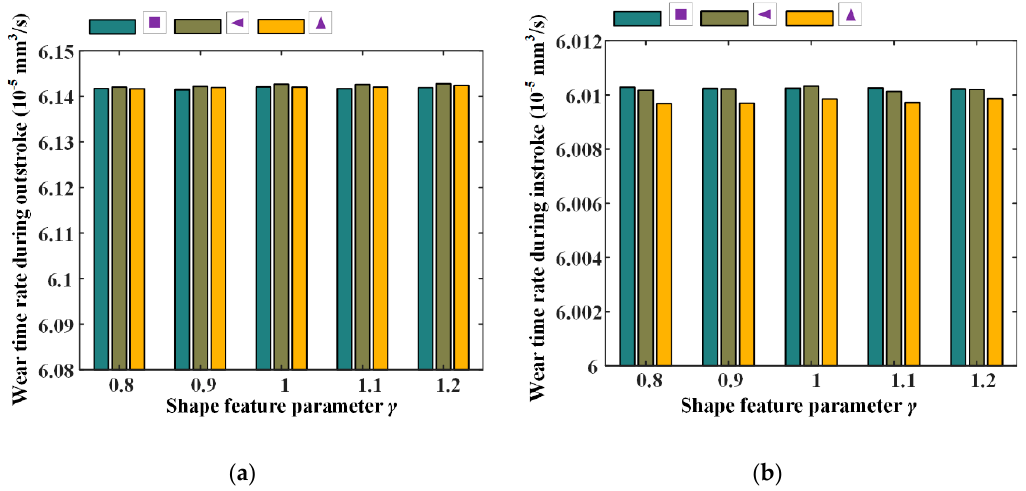
Figure 23. The relationship between wear time rate and texture depth, ( a ) outstroke, ( b ) instroke.